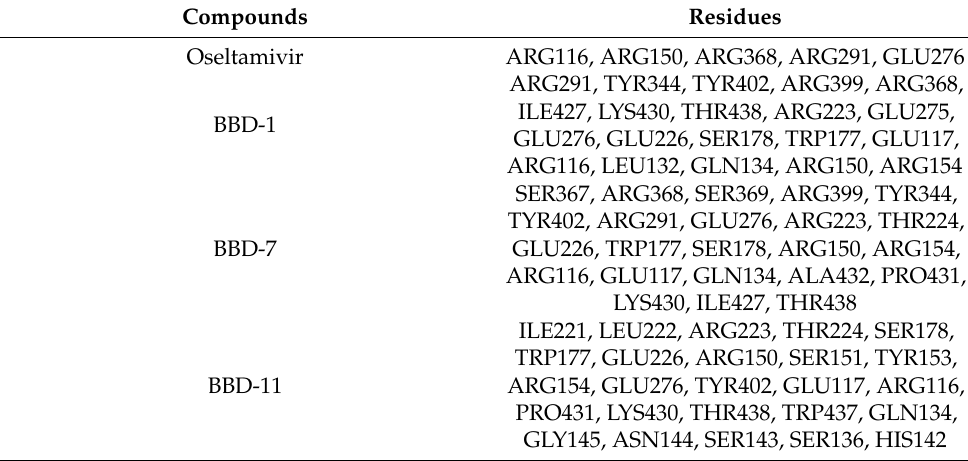
Table 3. The binding interaction residues registered between NA and compounds (distance five